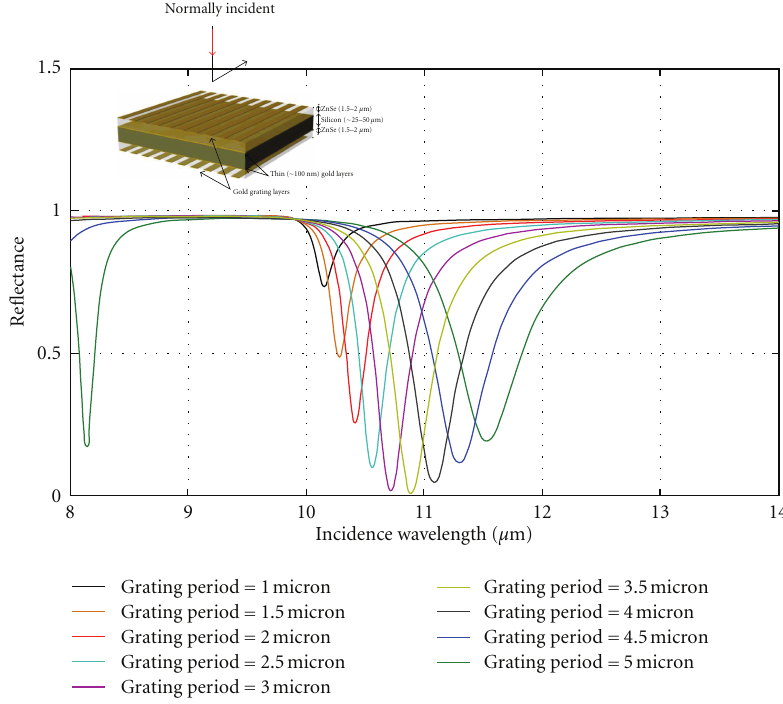
Figure 5: Simulation results, using the RCW method, that present the reflectance at normal incidence within the LWIR band as the gold grating period is varied from 1.0 to 5.0 µ m. For this simulation, the substrate thickness is fixed at 2.0 µ m with a grating duty cycle of 50%. The incident wave was normally incident with parallel